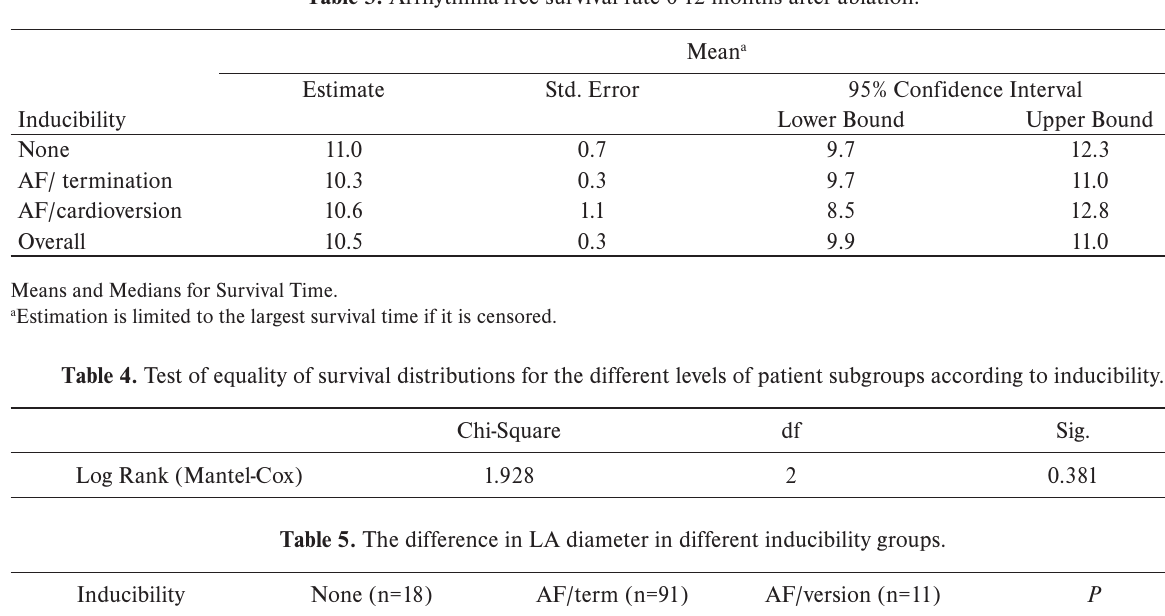
Table 3. Arrhythmia-free survival rate 0-12 months after ablation.